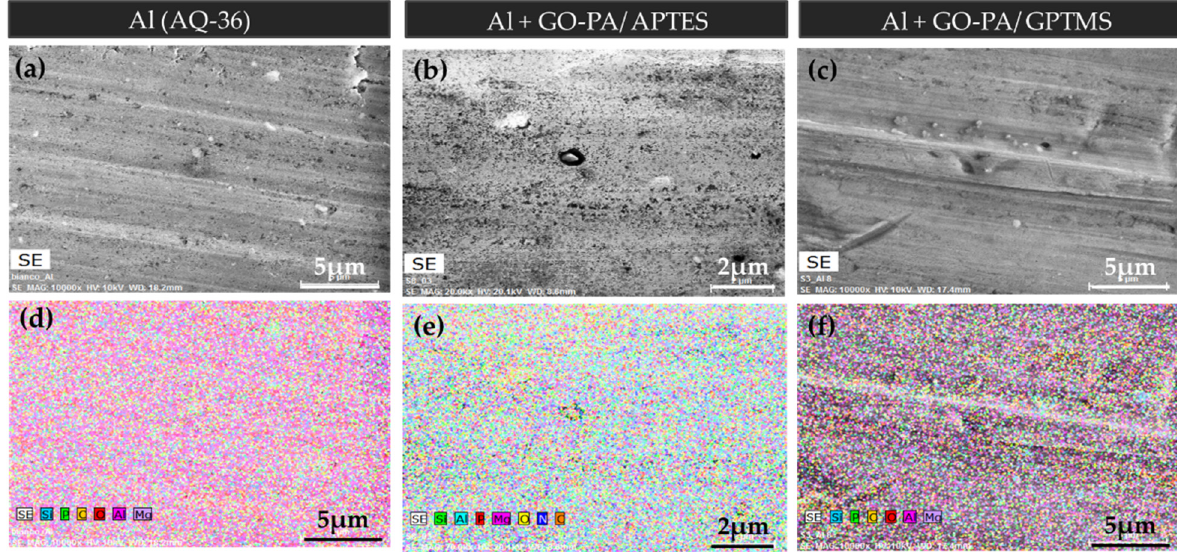
Figure 12. SEM images of no-treated aluminum substrate ( a ) and aluminum substrates treated with GO-PA/APTES ( b ) and GO-PA/GPTMS ( c ) coatings. EDX mapping of C, O, and P elements of the analyzed samples ( d – f ).